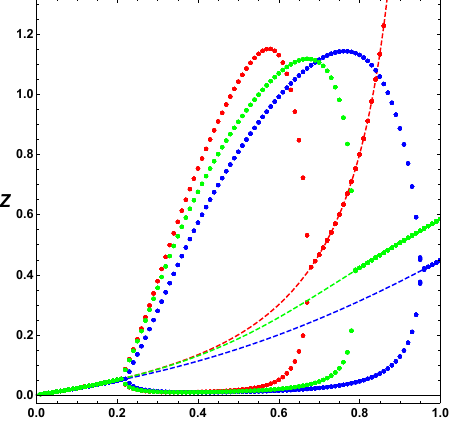
Figure 7. Poincare section of extrema, with k d = 1, k u = 0.01, K = 0.20 and φ = 0. Red implies constant input; blue implies m = 1; and green implies m = 2. See Equation